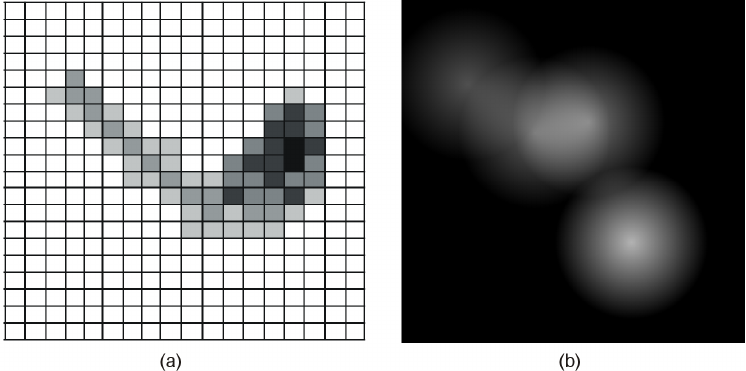
Figure 4. Examples of pheromone-based activity maps described in Refs. [42,43].